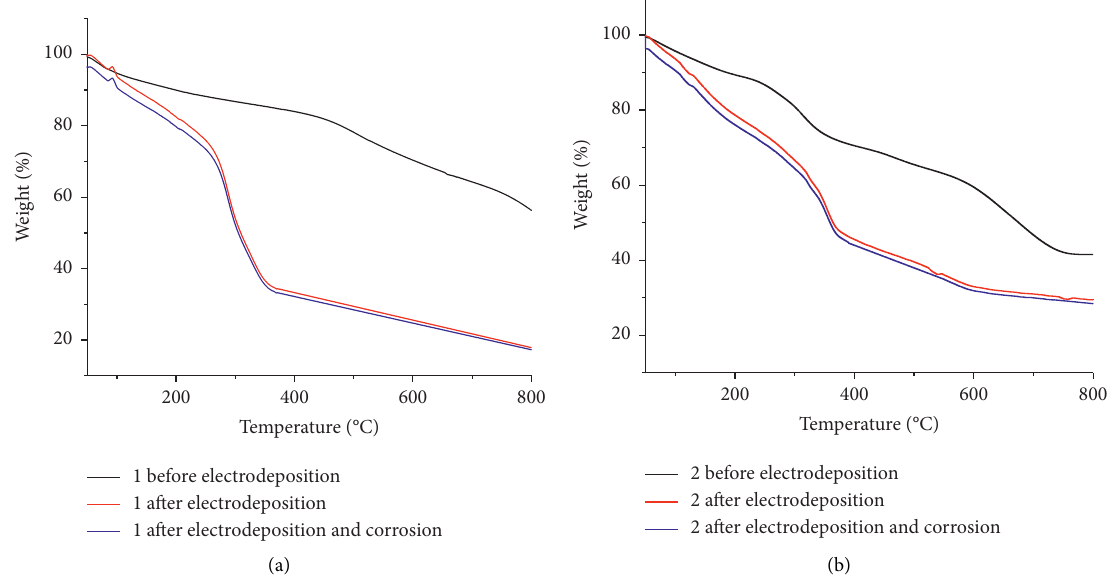
Figure 3: Thermogravimetric curves of phthalocyanine derivatives 1 (a) and 2 (b) before and after electrodeposition, heated at 20 ° C min − 1 from 50 to 800 ° C in